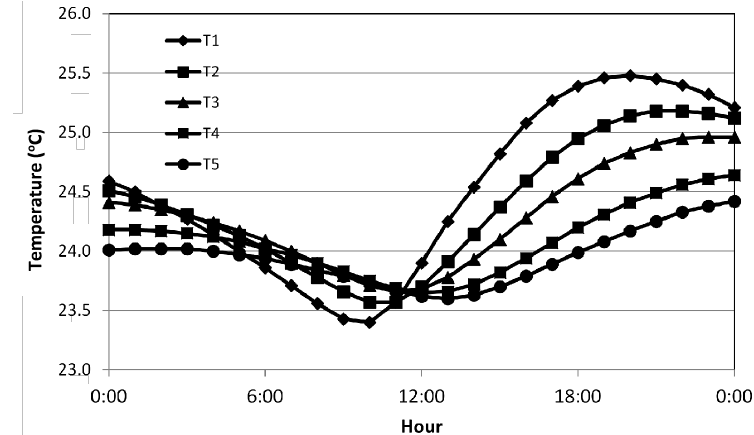
Figure 5. Temperature change in the wall for 9 August 2019.